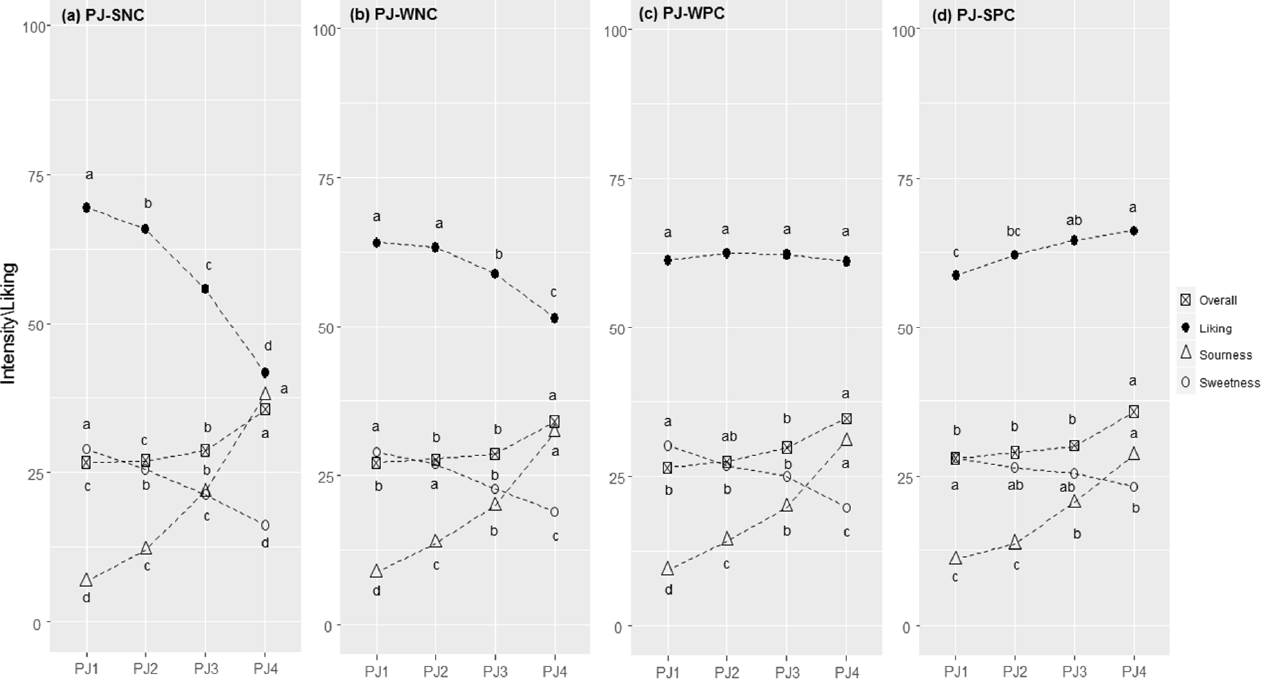
Figure 2. Pear juice (PJ) responses in each cluster (SNC = Strong Negative Correlation ( a ), WNC = Weak Negative Correlation ( b ), WPC = Weak Positive Correlation ( c ), and SPC = Strong Positive Correlation ( d )): perceived intensity (gLM scale) and liking (LAM scale) averages for each concentration level of citric acid (1–4). Within each cluster, different letters indicate significant differences in intensity/liking between concentration levels ( p <